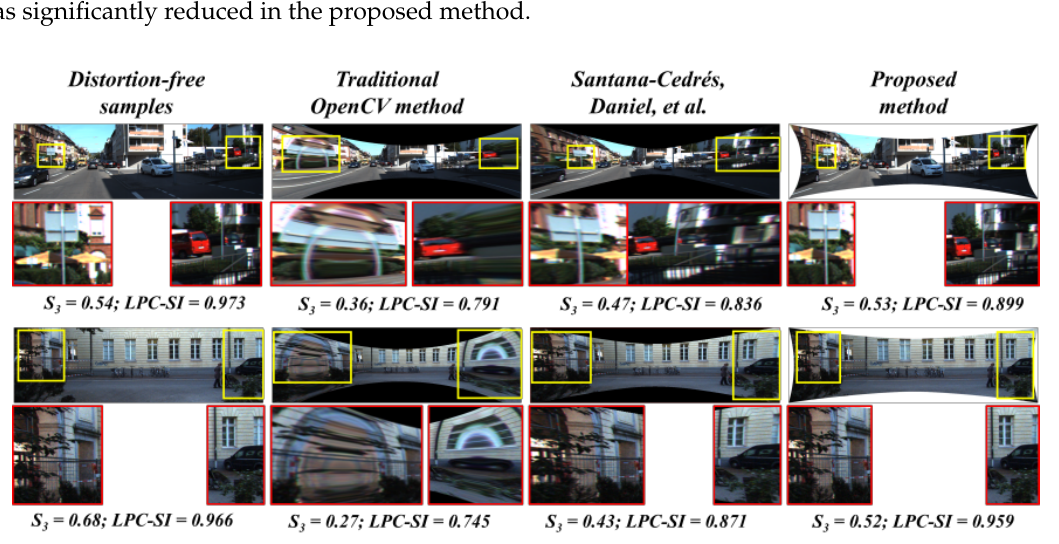
Figure 10. Qualitative analysis: pixel quality and